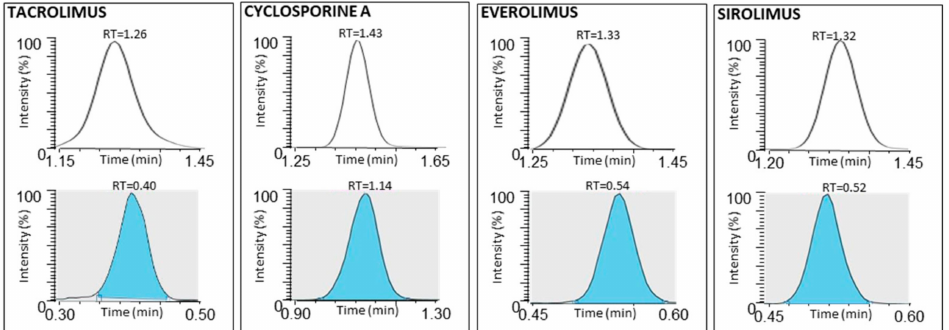
Figure 1. Upper chromatograms: representative chromatograms of level 4 calibrator (tacrolimus = 21.50 ng/mL; CsA = 483.00 ng/mL; everolimus = 22.60 ng/mL; sirolimus = 22.70 ng/mL) used for immunosuppressant quantitation obtained by Shimadzu–Recipe analysis. Lower chro- matograms: representative chromatograms of level 2 calibrator (tacrolimus = 2.19 ng/mL; CsA = 24.85 ng/mL; everolimus = 1.98 ng/mL; sirolimus = 1.90 ng/mL) used for immunosuppres- sant quantitation obtained by Cascadion.